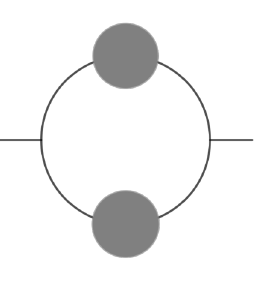
Figure 3 . The self-energy of the model. Full propagators are represented by the gray blobs.